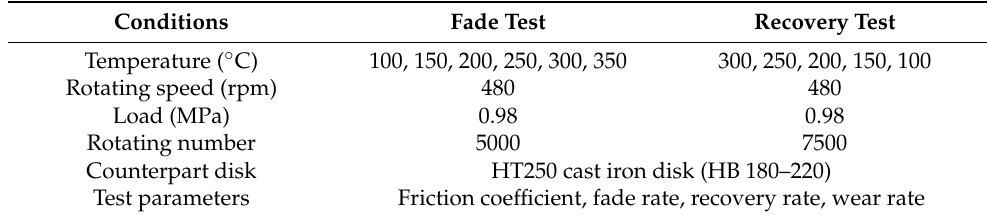
Figure 3. Experimental set-up: ( a ) constant-speed friction testing machine and ( b ) sample fixed device. Table 3. Tribological test conditions details.